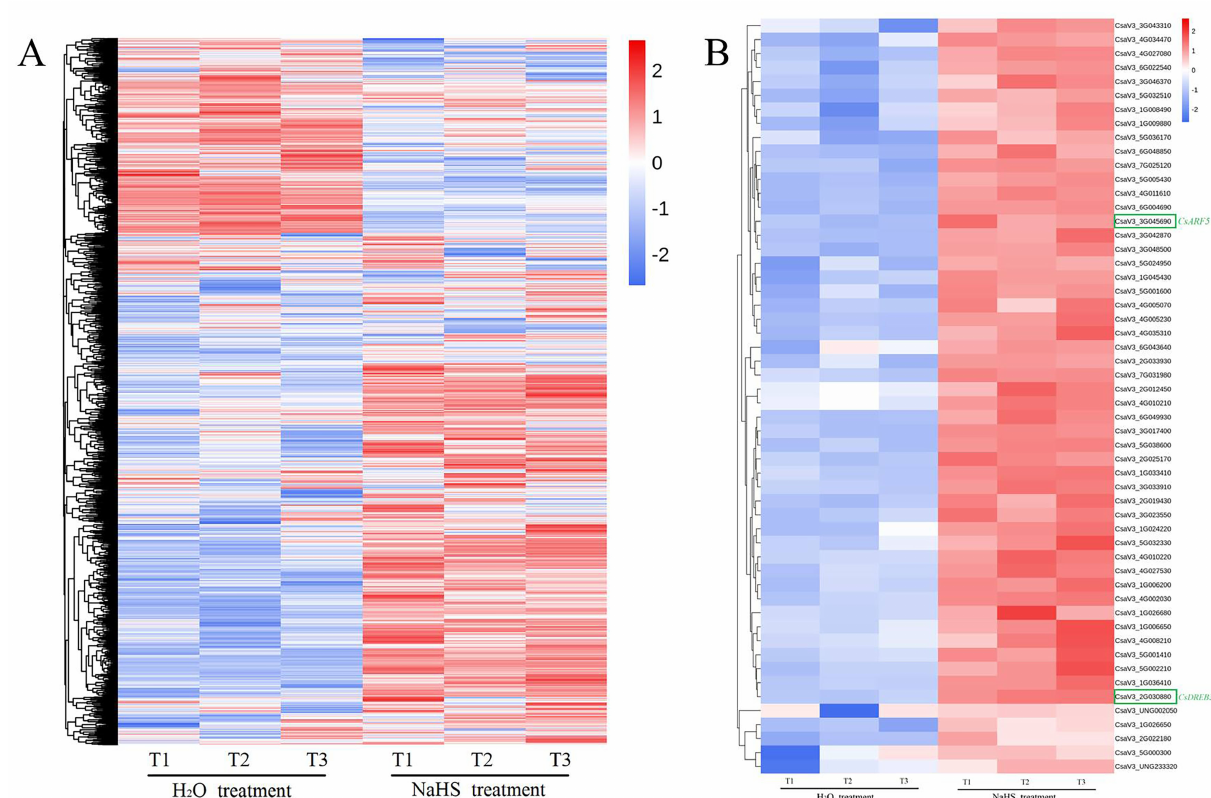
Figure 2. RNA-seq analysis of cucumber seedlings with or without NaHS treatment. ( A ) Normalized heat map showing the changes in gene expression after NaHS treatment at 5 ◦ C for 6 h. All experiments were performed in triplicate. ( B ) Normalized heat map of upregulated gene expression after NaHS treatment at 5 ◦ C for 6 h. All experiments were performed in